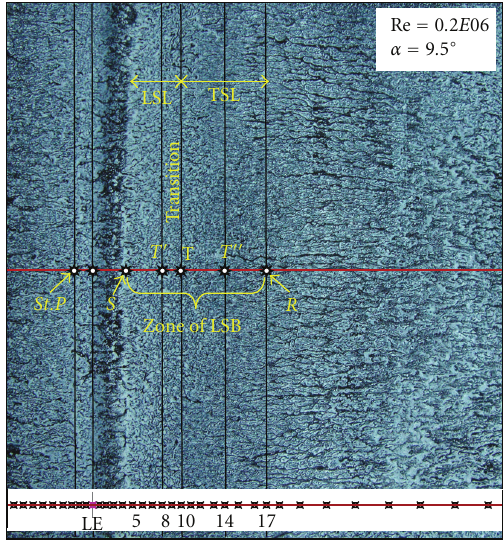
Figure 8: Surface flow